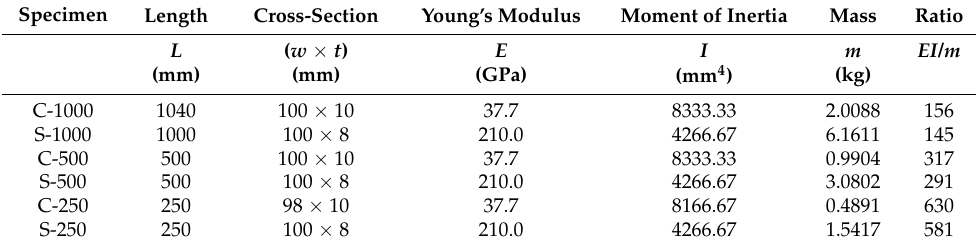
Table 13. Elastic properties set for the direct problem.